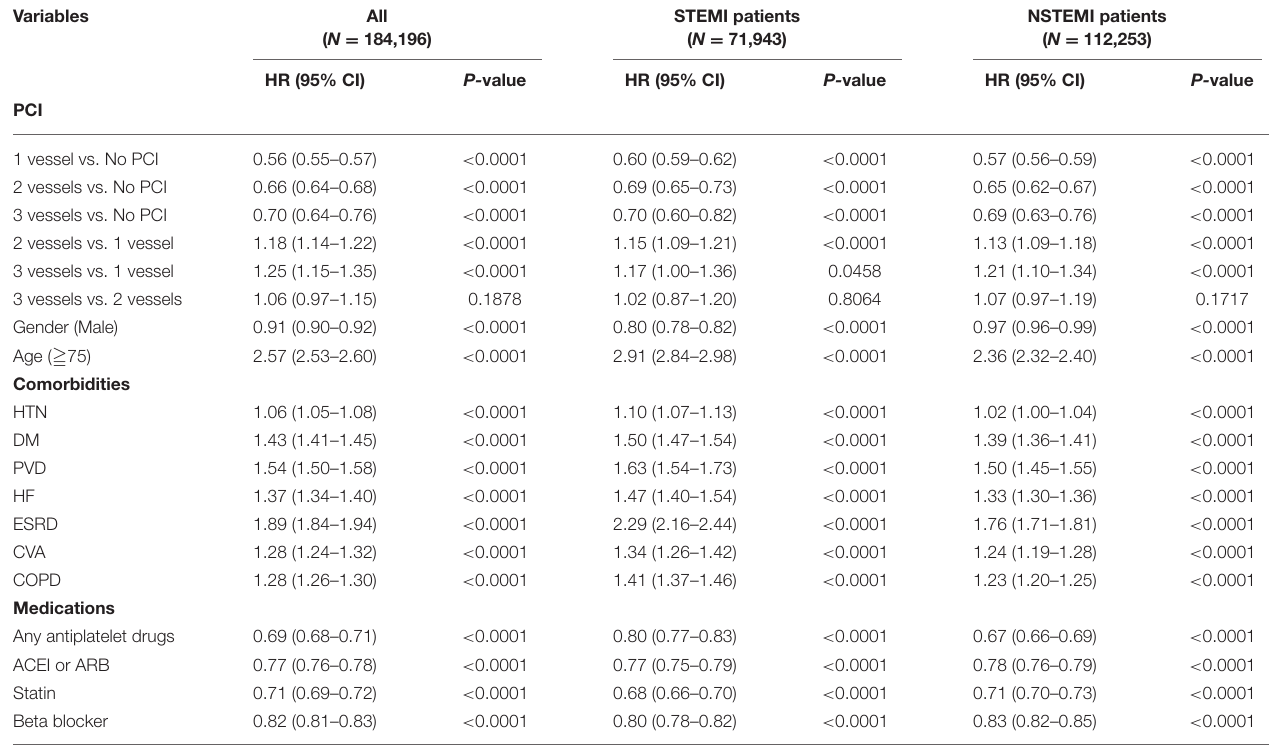
TABLE 3 | Cox proportional hazards regression analysis for hospitalized patients with first AMI and subgroup analysis of different AMI types.